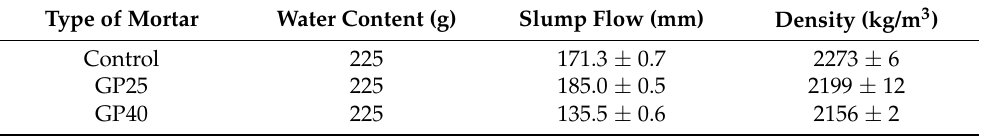
Table 5. Flow table results and density of the mortar mixes with cement replacement with GP.